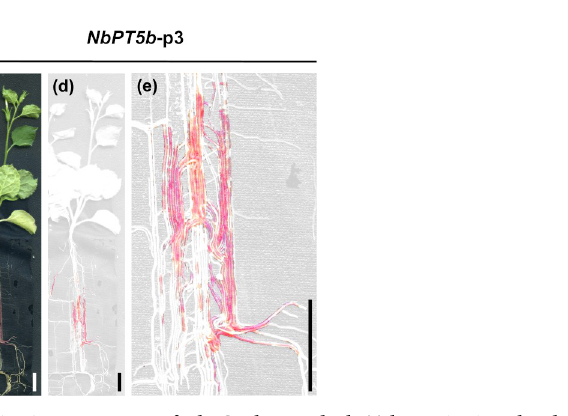
Fig 7. Red pigment distribution in root systems of NbBCP1b -p3 and NbPT5b -p3 Nicotiana benthamiana plants colonised by Rhizophagus irregularis . Images were taken at 52 dpi. (a and c) are reflective light images, and (b, d, and e) are filtered for red colouring only. (e) High magnification image of (d) showing varying red colouration in parallel running roots. Scale bar = 1.3 cm. dpi, days postinoculation.